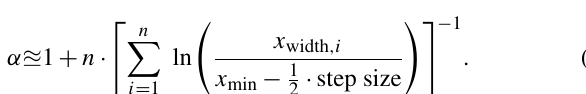
the power-law exponent α